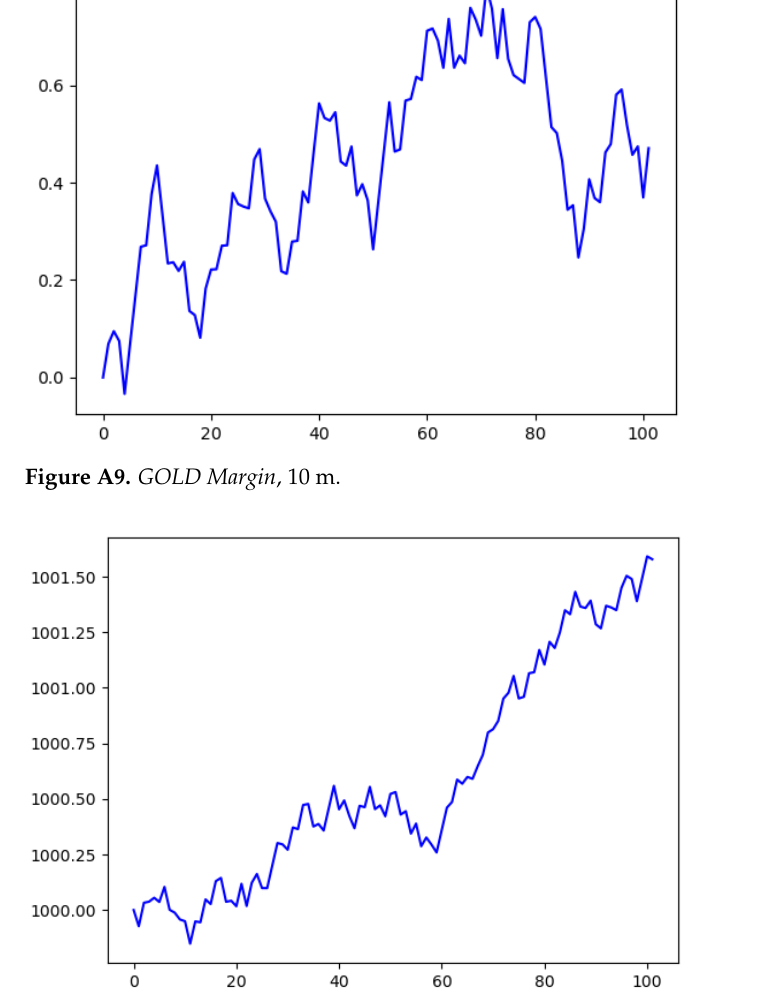
Figure A10. EURUSD Margin , 12